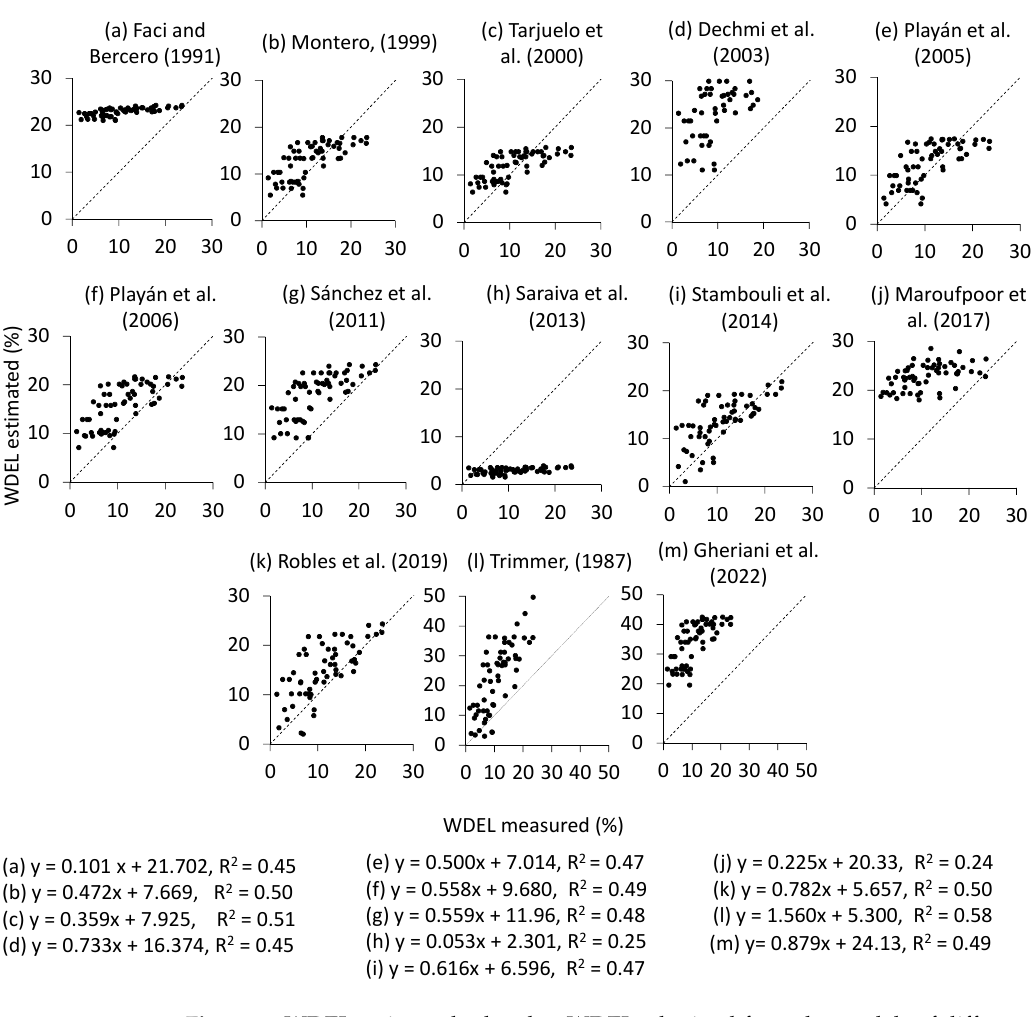
Figure 8. WDEL estimated related to WDEL, obtained from the models of different impact sprinkler research works. Linear regressions and determination coefficient (R 2 ) are reported for each correlation.